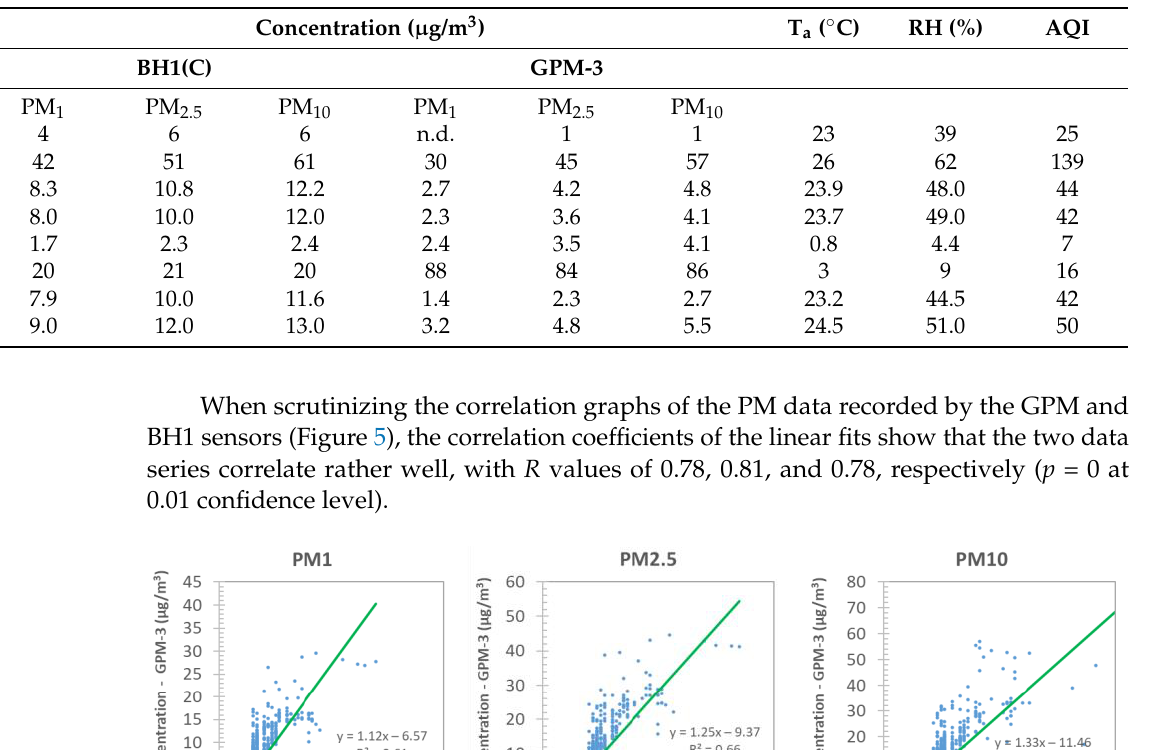
Table 4. Statistics of air monitoring data for GPM-type and BH1 sensors collected indoors (anteroom)